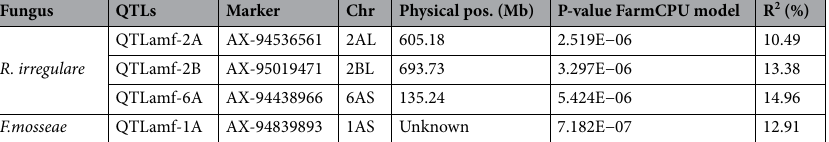
Table 5. Significant marker trait associations (MTAs) and corresponding quantitative trait loci (QTLs) for root colonization of tetraploid wheats ( Triticum turgidum ) by arbuscular mycorrhizal fungi. Chr., chromosome; Physical Pos., position on the chromosome in Mb; R 2 , variance explained by marker in percentage